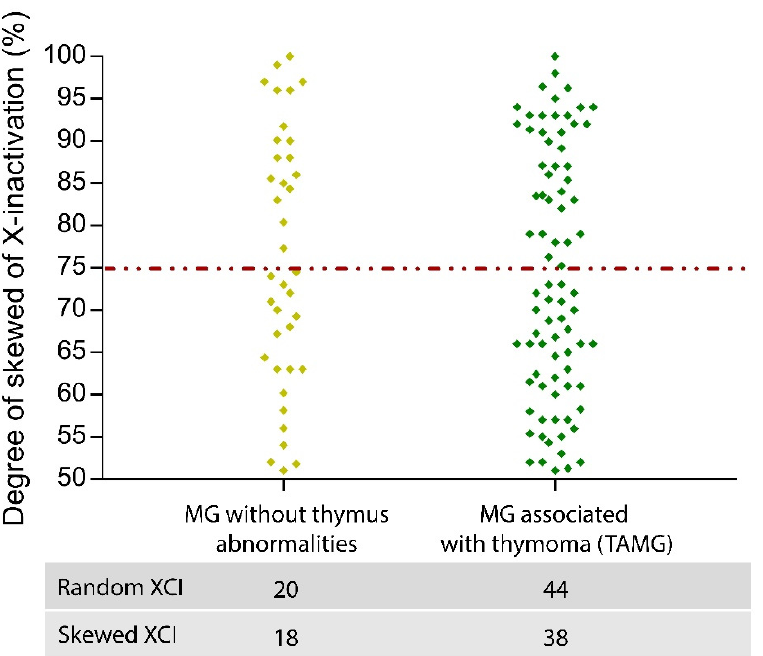
Figure 2. Distribution pattern of XCI in MG women with and without thymus abnormalities. The distribution of XCI patterns in the two MG subgroups is shown. Compared with 45% of TAMG, 47% of MG showed skewed inactivation. Therefore, it was not possible to detect significant differences in the chromosomal inactivation of MG and TAMG patients.